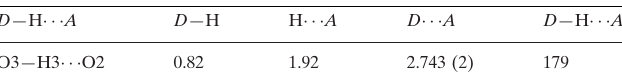
Hydrogen-bond geometry (A˚ , (cid:3)